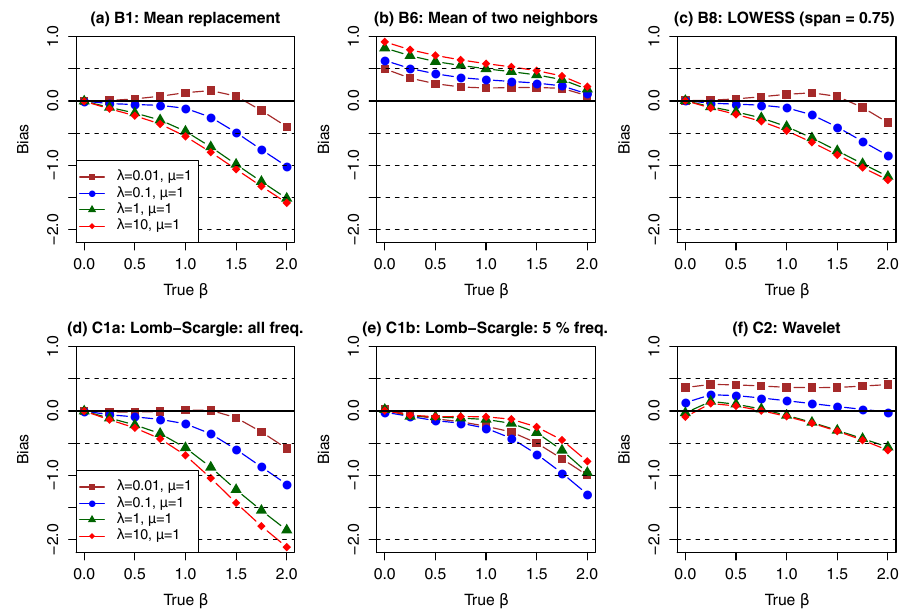
Figure 6. Comparison of bias in estimated spectral slope in irregular data that are simulated with varying prescribed β values (100 replicates), a series length of 9125, and a mean gap interval of 2 (i.e., µ = 1).